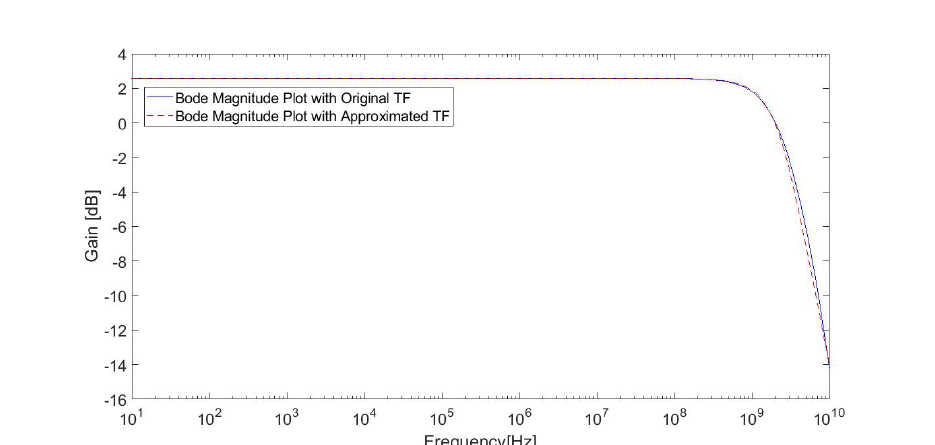
Figure 6. Bode magnitude of the CMOS differential stage shown in Figure 5, simulated using CMOS technology of 180 nm, and comparing the original TF versus the symbolic